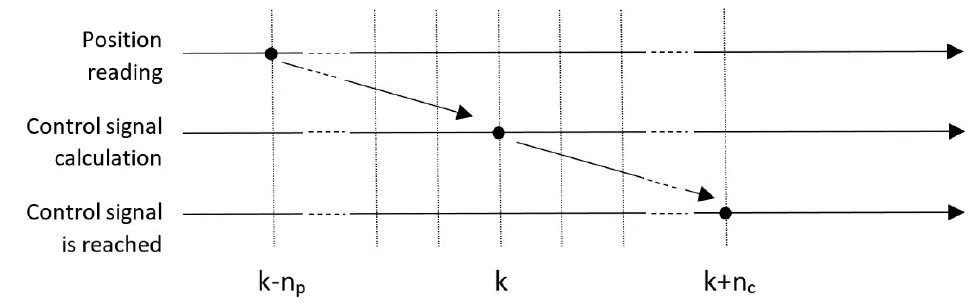
Figure 7. Delays involved in the control system.